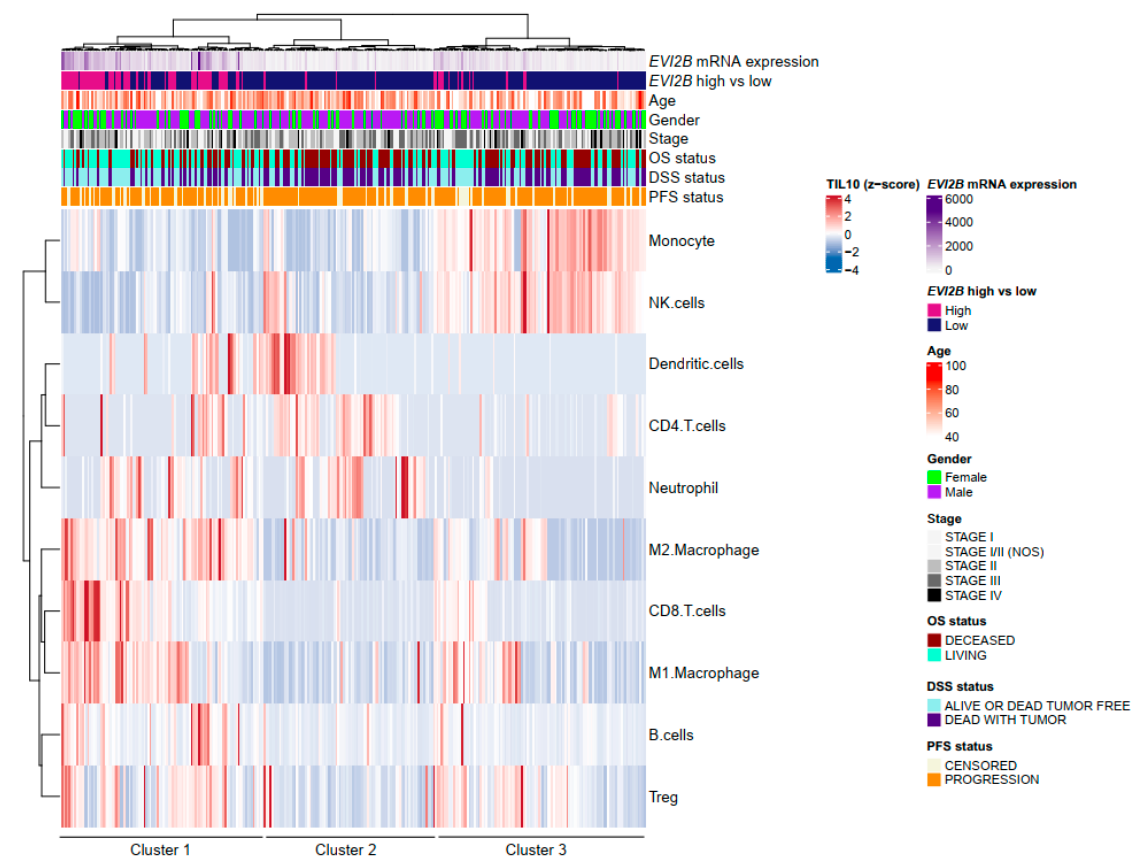
Figure 3. Heatmap of estimated TIL fractions by quanTIseq estimation [17] and clinical data showing three clusters in metastatic melanoma patients by non-hierarchical clustering.